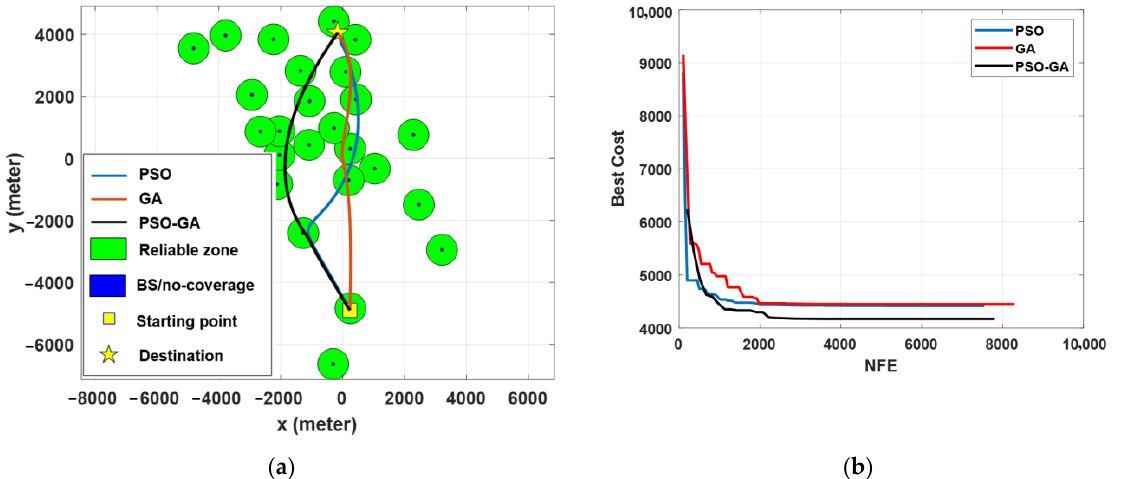
Figure 10. Simulation results of different optimization algorithms in Scenario II: ( a ) path planning results and ( b ) cost function value vs. the number of function evaluations.